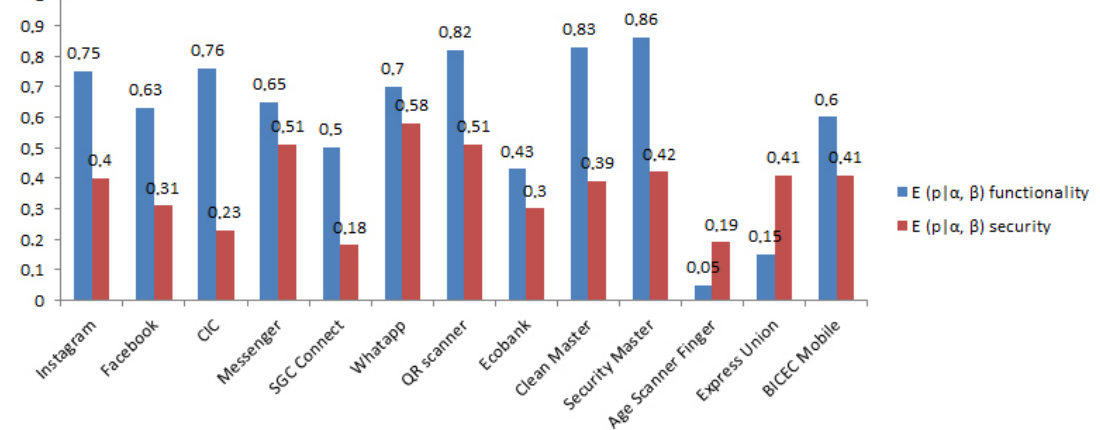
Figure 4. Reputation-based security vs. reputation-based